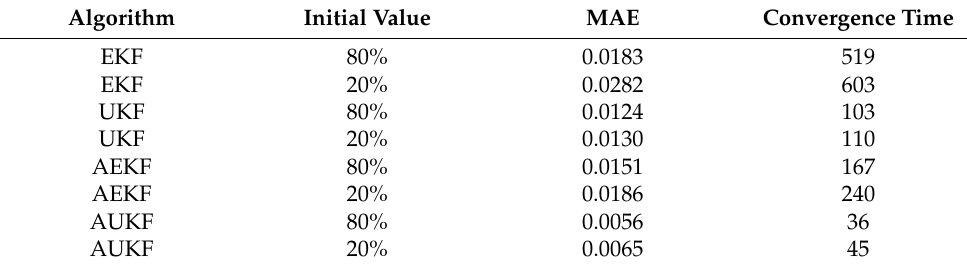
Table 7. Comparison results of the four calculation methods via the